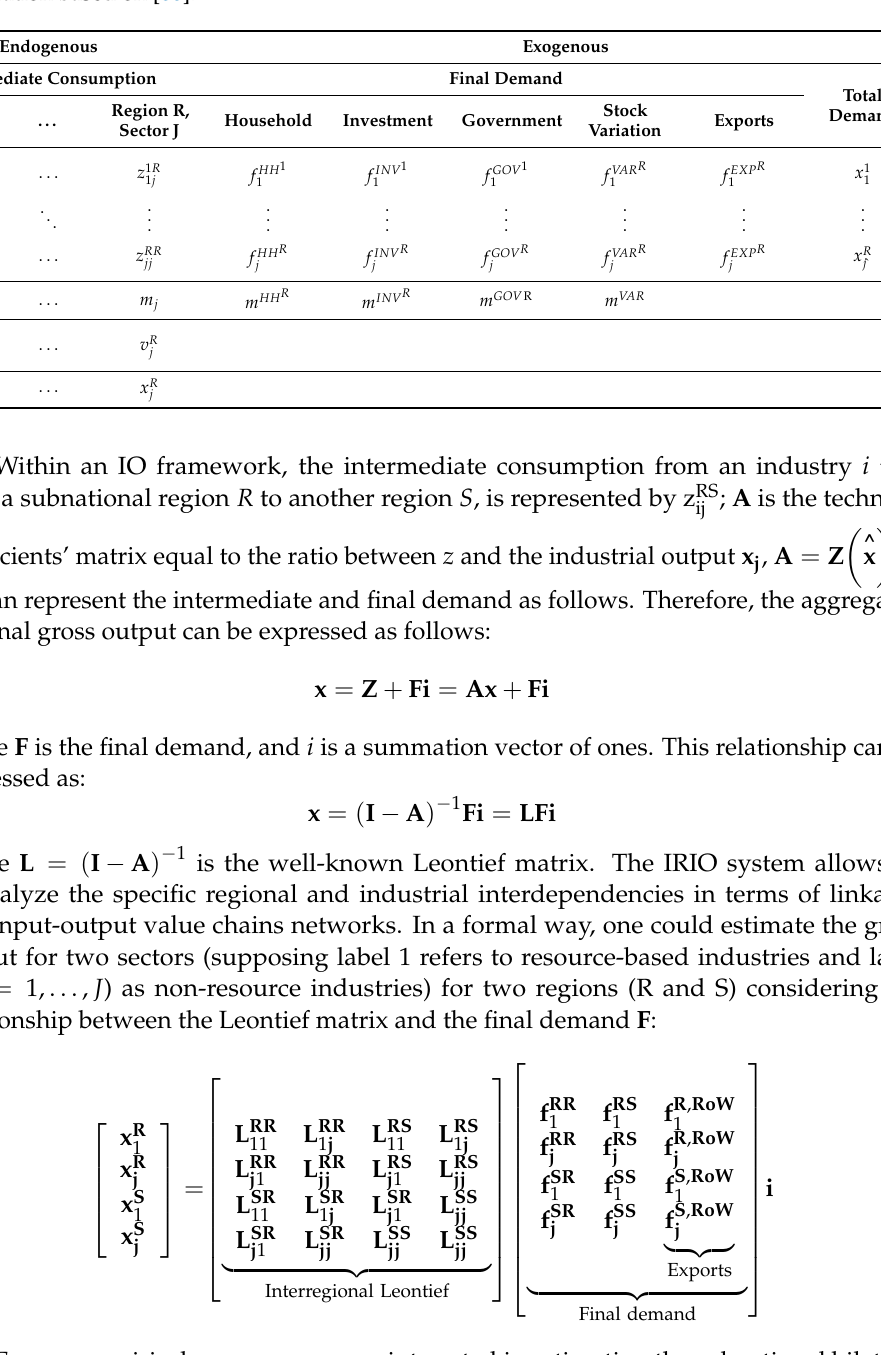
Table 3. An interregional IO table with R regions and J industries (groups). Source: Authors’ elaboration based on